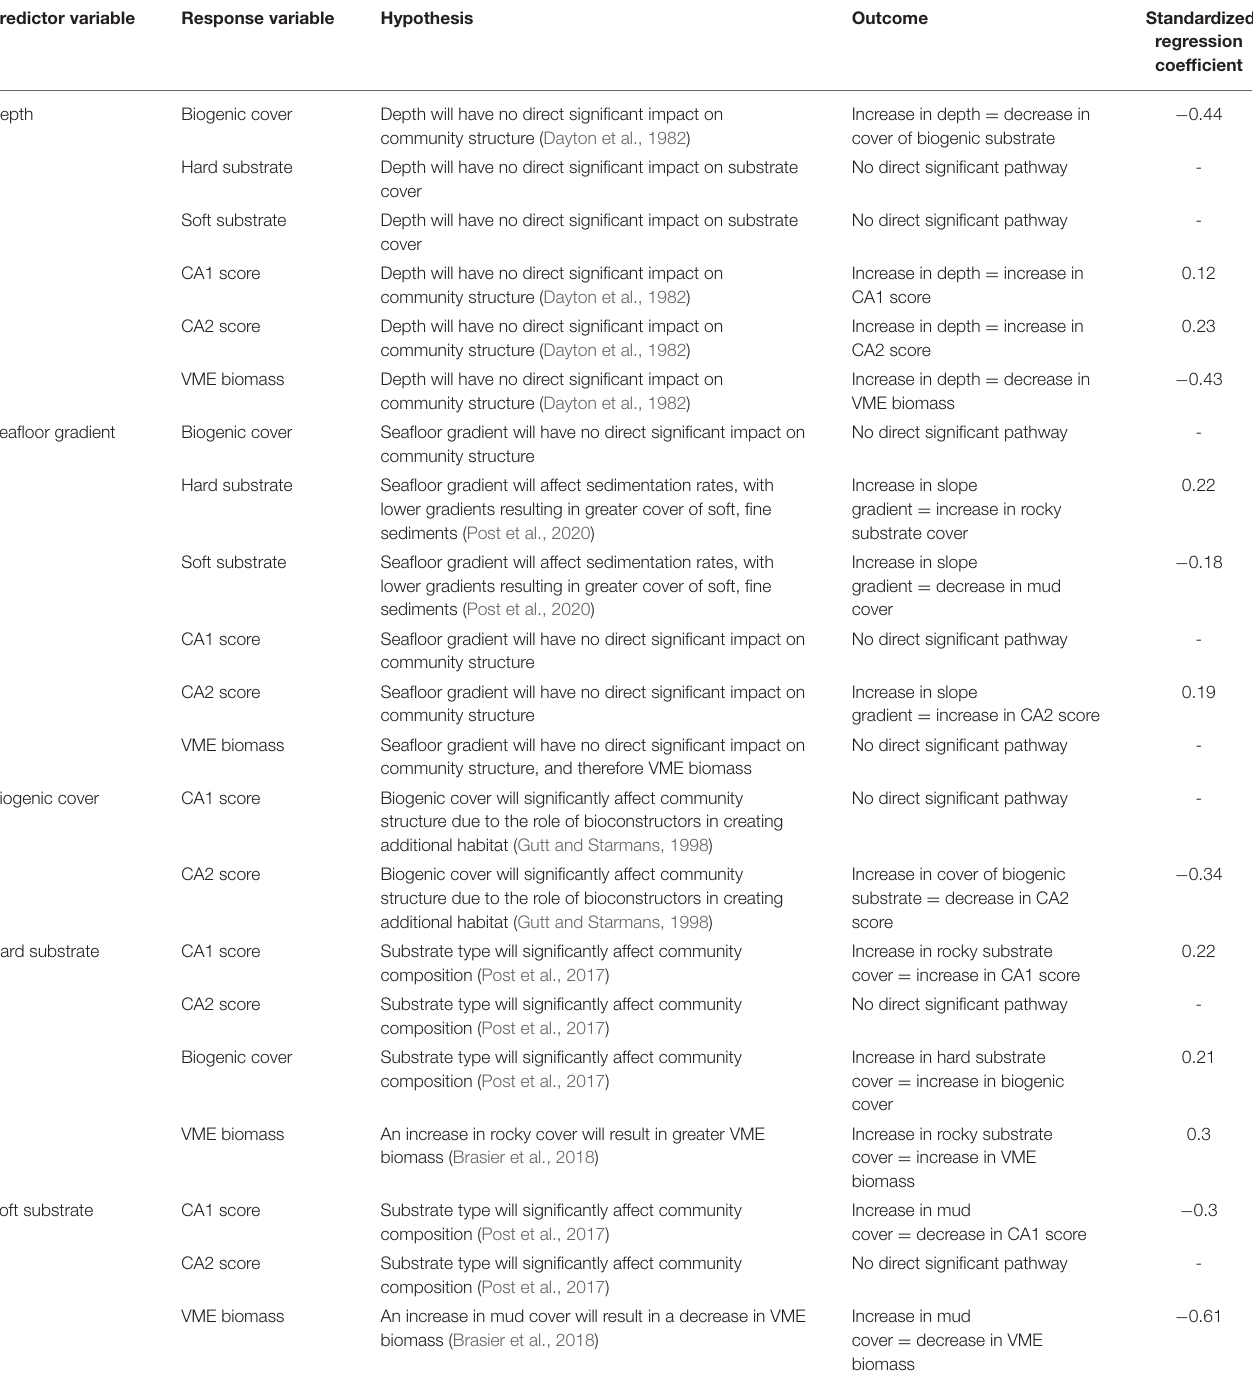
TABLE 6 | Summary of all direct pathways investigated using structural equation models and the hypothesis underpinning the expected relationship between predictor and response variables. Predictor